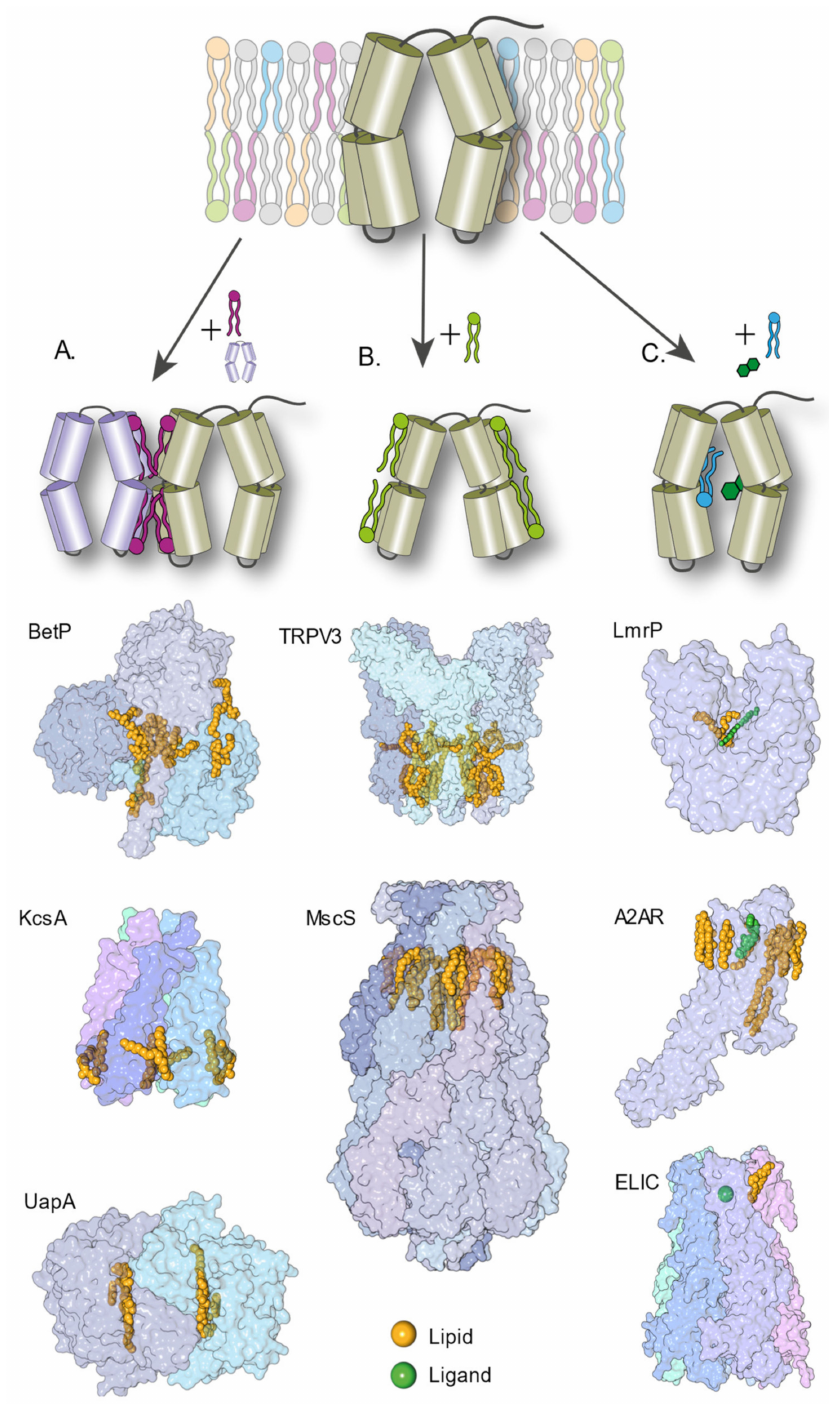
Figure 1. Schematic representation of known molecular mechanisms mediated by lipids and repre- sentative examples of lipid–protein complexes captured in high-resolution structures ( A ). Lipids as regulators of protein oligomerization and complex assembly. Cartoon representation of BetP (PDB ID 4C7R), KcsA (PDB ID 3IFX) and UapA (PDB ID 5I6C) proteins. ( B ). Lipid regulating conformational dynamics. Cartoon representation of TRPV3 (PDB ID 6LGP) and MscS (PDB ID 6PWN) proteins ( C ). Lipids modulating ligand binding directly (competition) or indirectly (allostery). Cartoon representa- tion of LmrP (PDB ID 6T1Z), A2AR (PDB ID 5IUA) and ELIC (PDB ID 6HJX) proteins. PDB figures were generated using ‘The Protein Imager’